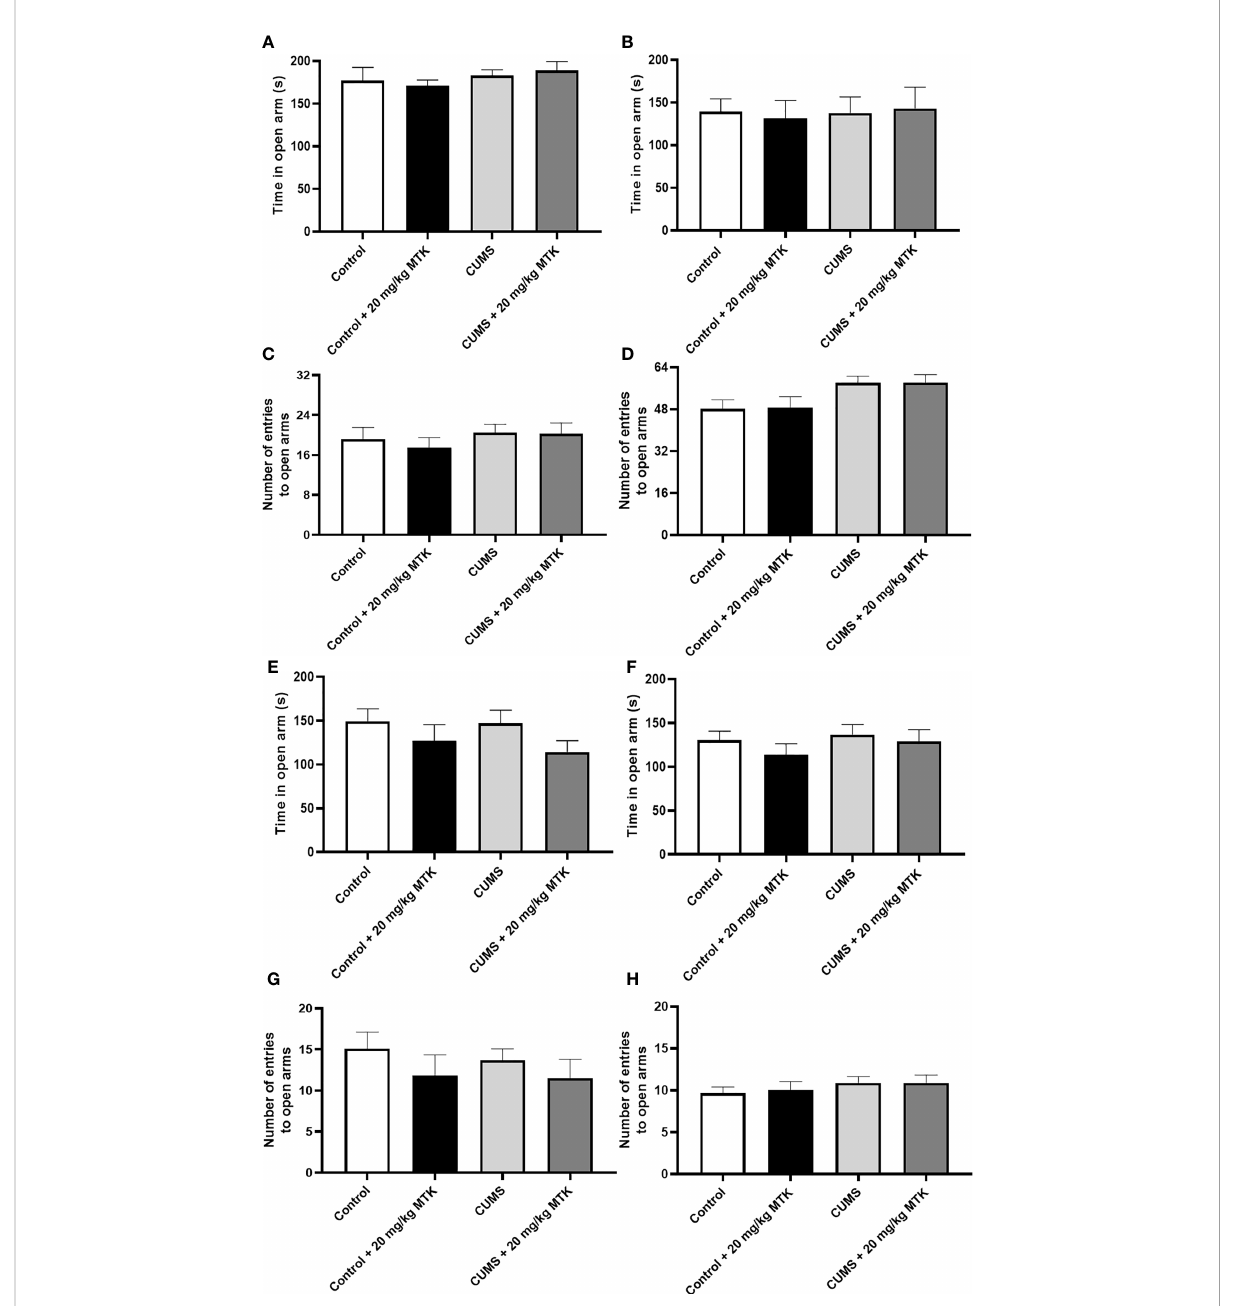
FIGURE 5 Effects of MTK on rats' behavior in the elevated plus-maze test. Male (A, C, E, G) and female (B, D, F, H) rats were exposed to CUMS or control conditions for four weeks (A-D) and then, while remaining under these conditions, were treated for two weeks with MTK 20 mg/kg or vehicle (E-H) . Time spent in open arms (A, B, E, F) and number of entries into the open arms (C, D, G, H) were evaluated. Each column is the mean ± SEM of 12 to 18 rats per group. Using one-way ANOVA (with Benjamini – Hochberg False Discovery Rate), followed by Student ’ s t-test for speci fi c group comparisons, no signi fi cant differences between the groups were